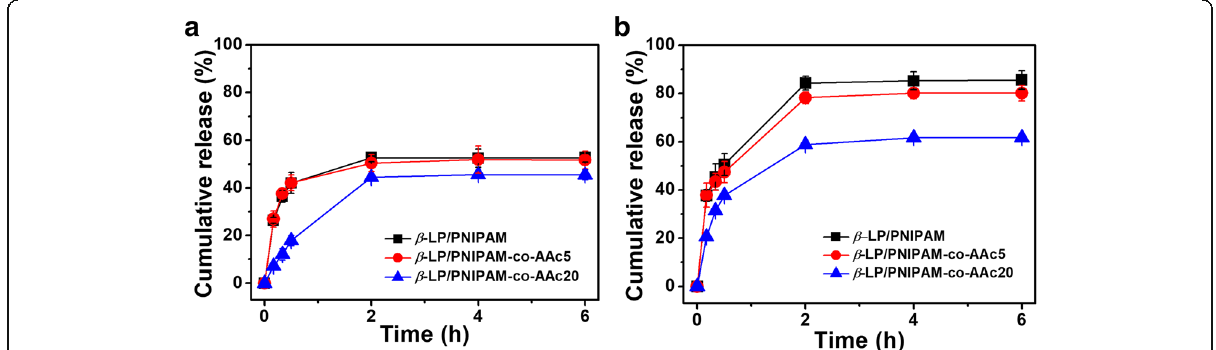
Fig. 4 Cumulative release of β -LP from PNIPAM, PNIPAM-co-AAc5, and PNIPAM-co-AAc20 nanogels at temperatures of a room temperature (24 °C) and b body temperature (37 °C) and pH